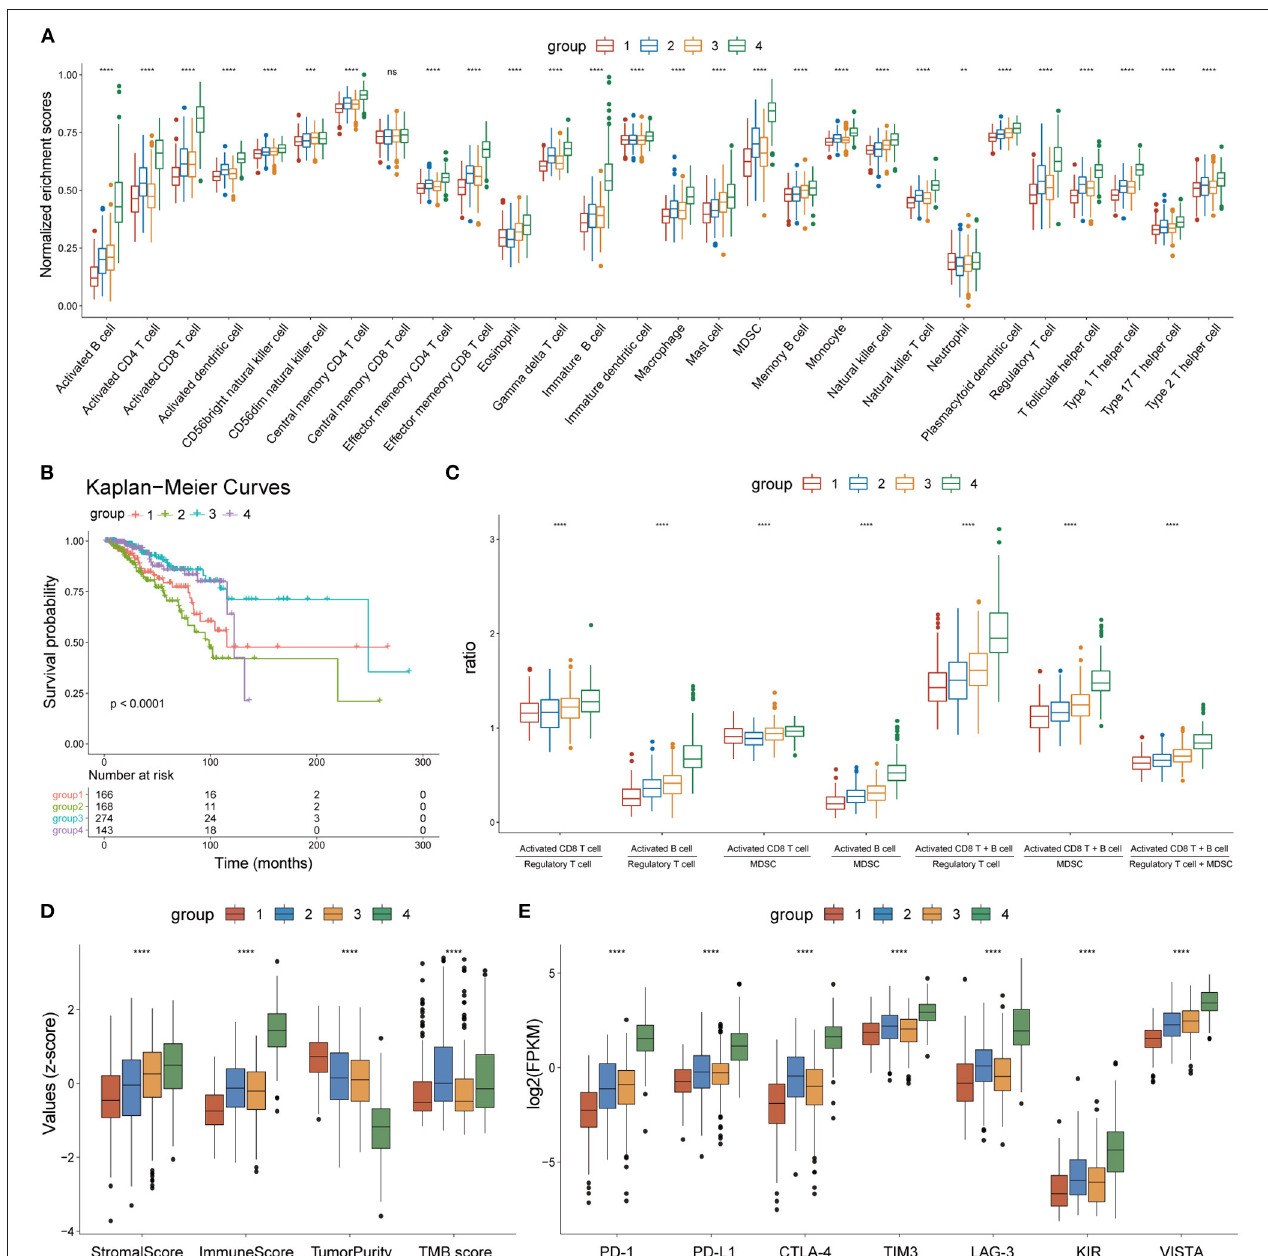
FIGURE 5 | Heterogeneity of the four subgroups. (A) Box plot showing enrichment scores of 28 immune cell types between the four subgroups. (B) Overall survival curves of the four subgroups. (C) Box plot showing the ratio of immune activation to immune suppression in the four subgroups. (D) Box plot showing the distribution of immune scores, stromal scores, tumor purity, and TMB scores in the four subgroups, The scores of each character were normalized by the z -score method. (E) Box plot showing the expression levels of seven immune checkpoint molecules. * p < 0.05, ** p < 0.01, *** p < 0.001, **** p <